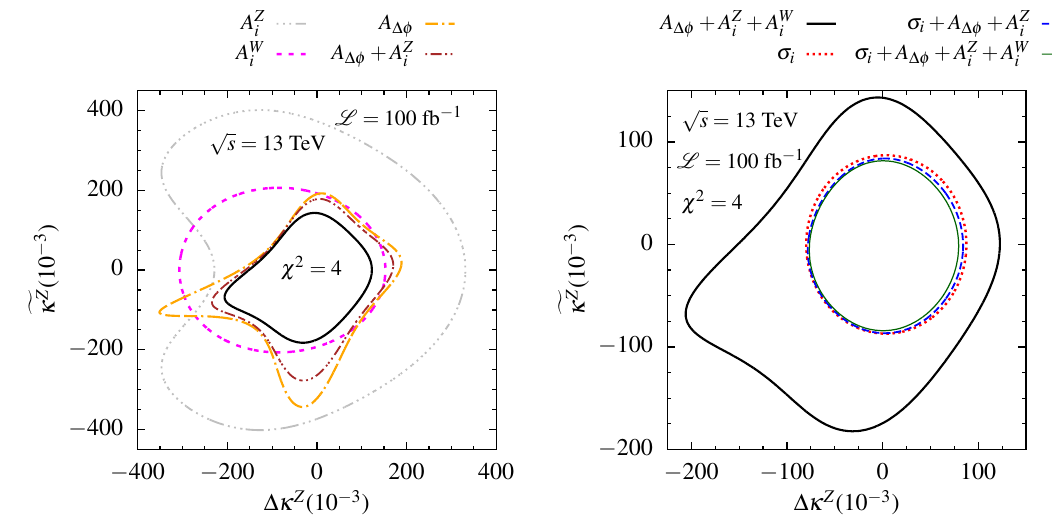
Figure 7 . The (cid:31) 2 = 4 contours are shown in the (cid:1) (cid:20) Z { their combinations in the left-panel , various combinations of the cross sections and asymmetries in the right-panel for p s = 13 TeV and L = 100 fb (cid:0) 1 . The contour for A (cid:1) (cid:30) + A Z solid /black line ) is repeated in both panel for